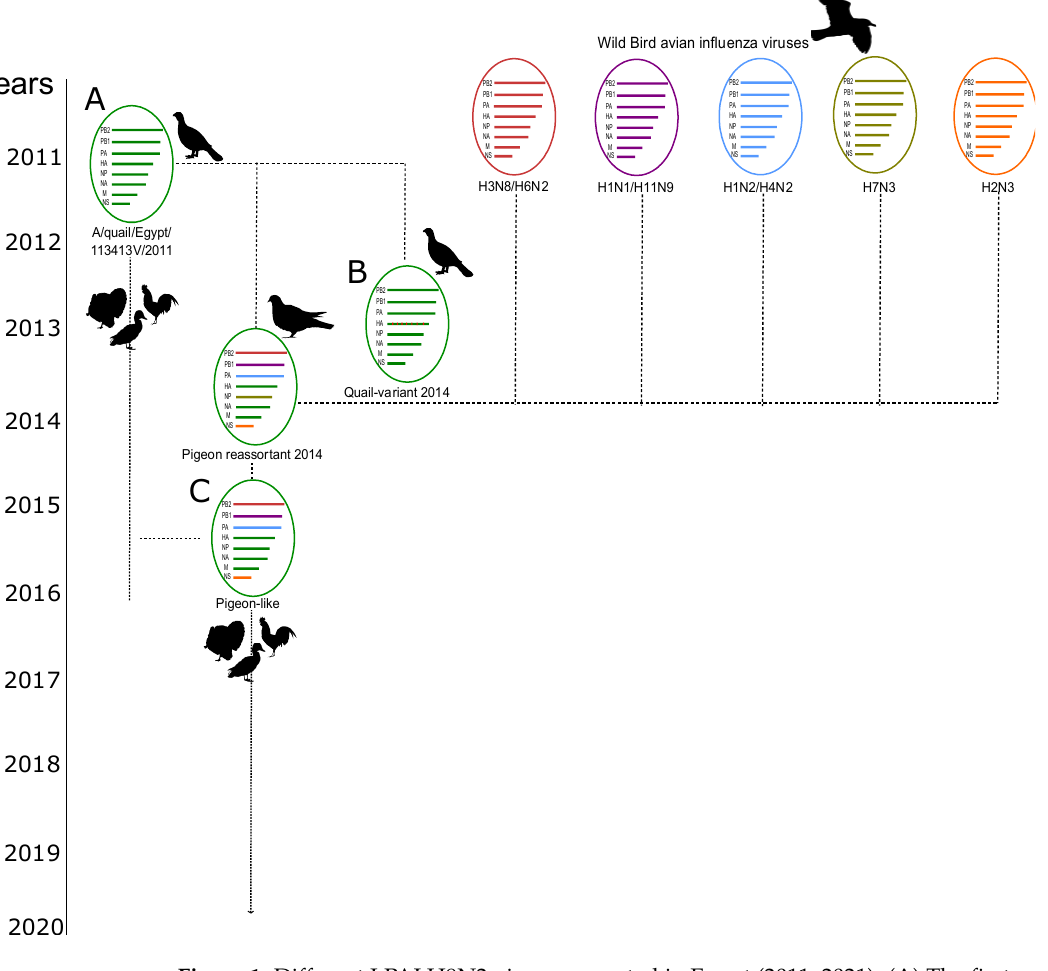
Figure 1. Different LPAI H9N2 viruses reported in Egypt (2011-2021). ( A ) The first reported LPAI H9N2 virus variant (A/quail/113413V/2011) in Egypt in 2011. ( B ) The quail/14864V/2014 variant detected in Egypt in 2014. ( C ) The recently circulating LPAI H9N2 variant in Egypt that harbors the PB2, PB1, PA, and NS genes from the pigeon variant and the rest of the genes from the Egyptian A/quail/113413V/2011-like variants. The three virus strains ( A , B , and C ) were used for the chicken experiment. Silhouettes of duck (by Maija Karala) and Pigeon (by Dori (dori@merr.info) and Nevit Dilmento) were retrieved from PhyloPic (http://phylopic.org, accessed on 11 January 2022) under a CC BY-NC-SA-3.0 license (https://creativecommons.org/licenses/by-nc-sa/3.0/). Other silhouettes were downloaded from the same cite under a CC0 1.0 Universal (CC0 1.0) license